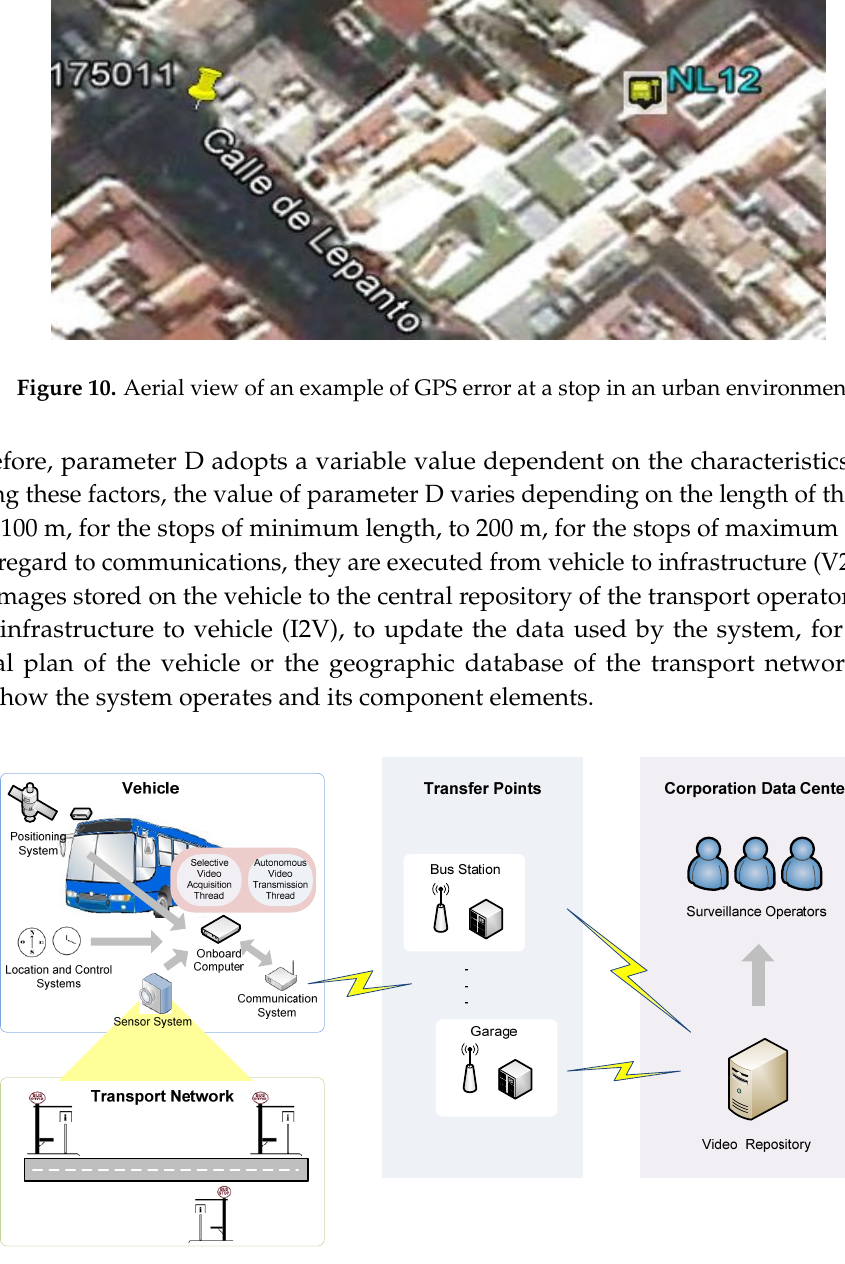
Table 2. Bus stop surveillance system context matrix.